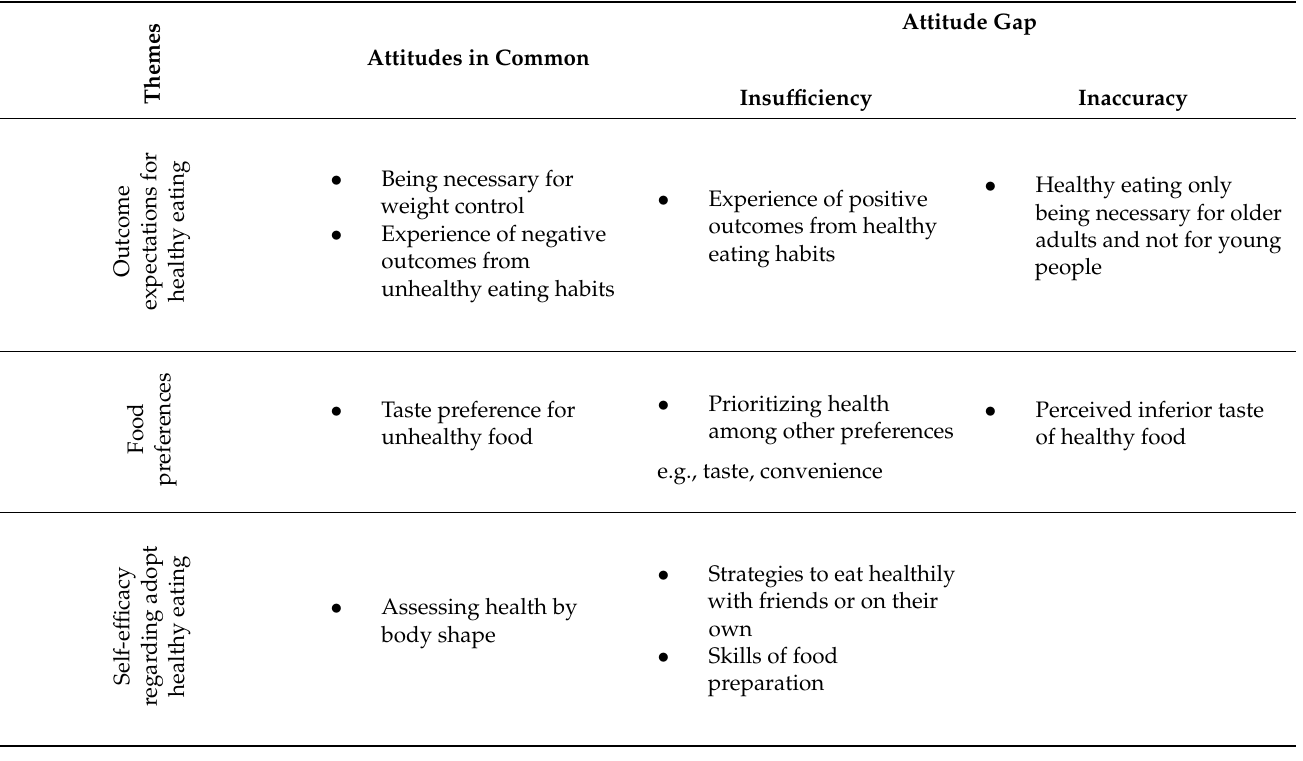
Table 4. Summary of themes on adolescent attitudes towards healthy eating.